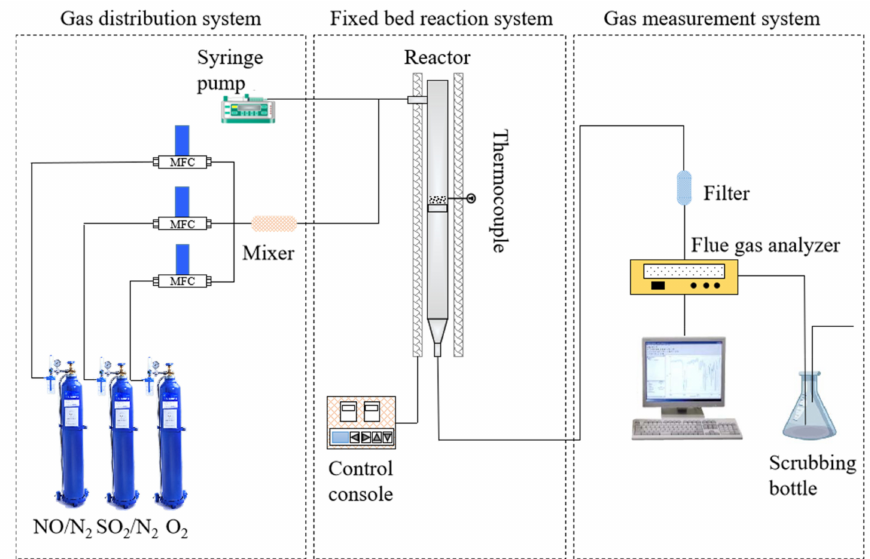
Figure 1. System diagram of activated coke adsorption experiment